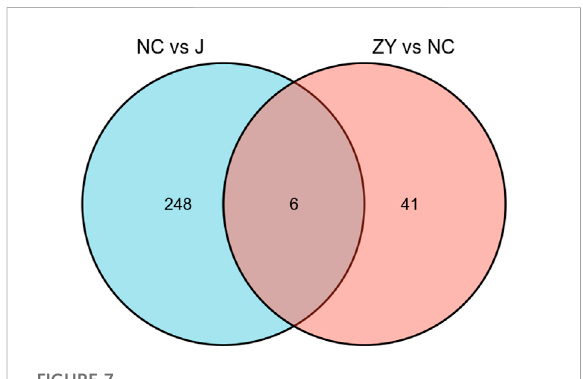
FIGURE 7 The Venn diagram indicated a comparison of DEPs between the NC group vs. J group and ZY group vs. NC group.